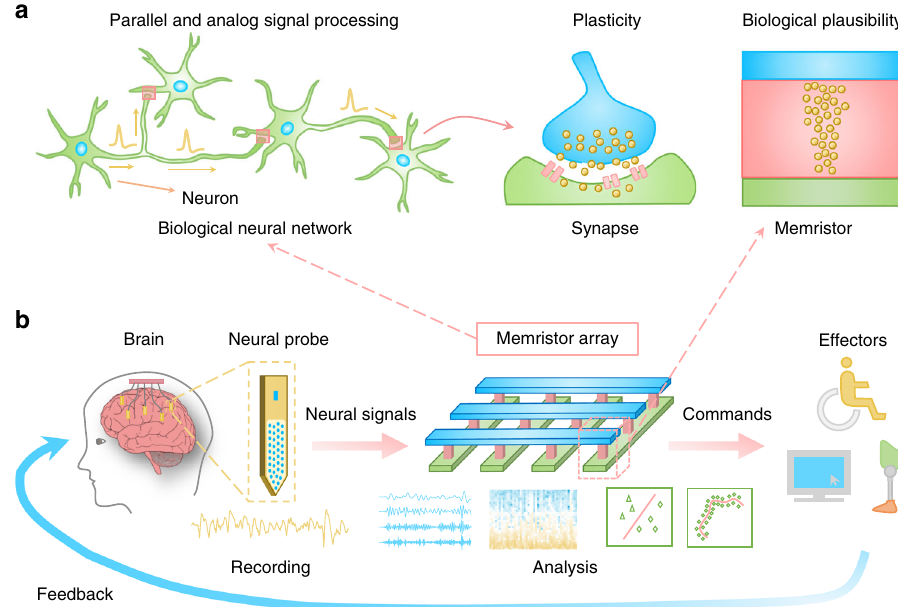
Fig. 1 Memristor-based neural signal analysis system for brain – machine interfaces (BMIs). a Motivations of using memristors for neural signal analysis. Memristor is analogous to biological synapse as they both show synaptic plasticity (change of its current state) via ion movements, and it has the ability to process analog signal directly as the neurons and synapses do. The memristor array further enables parallel processing of signals, which is one of the key features of the brain. b Conceptual diagram of a future BMI that integrates memristor-based neural signal analysis system. Neural activities recorded by the neural probes are analyzed through the memristor array to obtain commands for effectors in various BMI